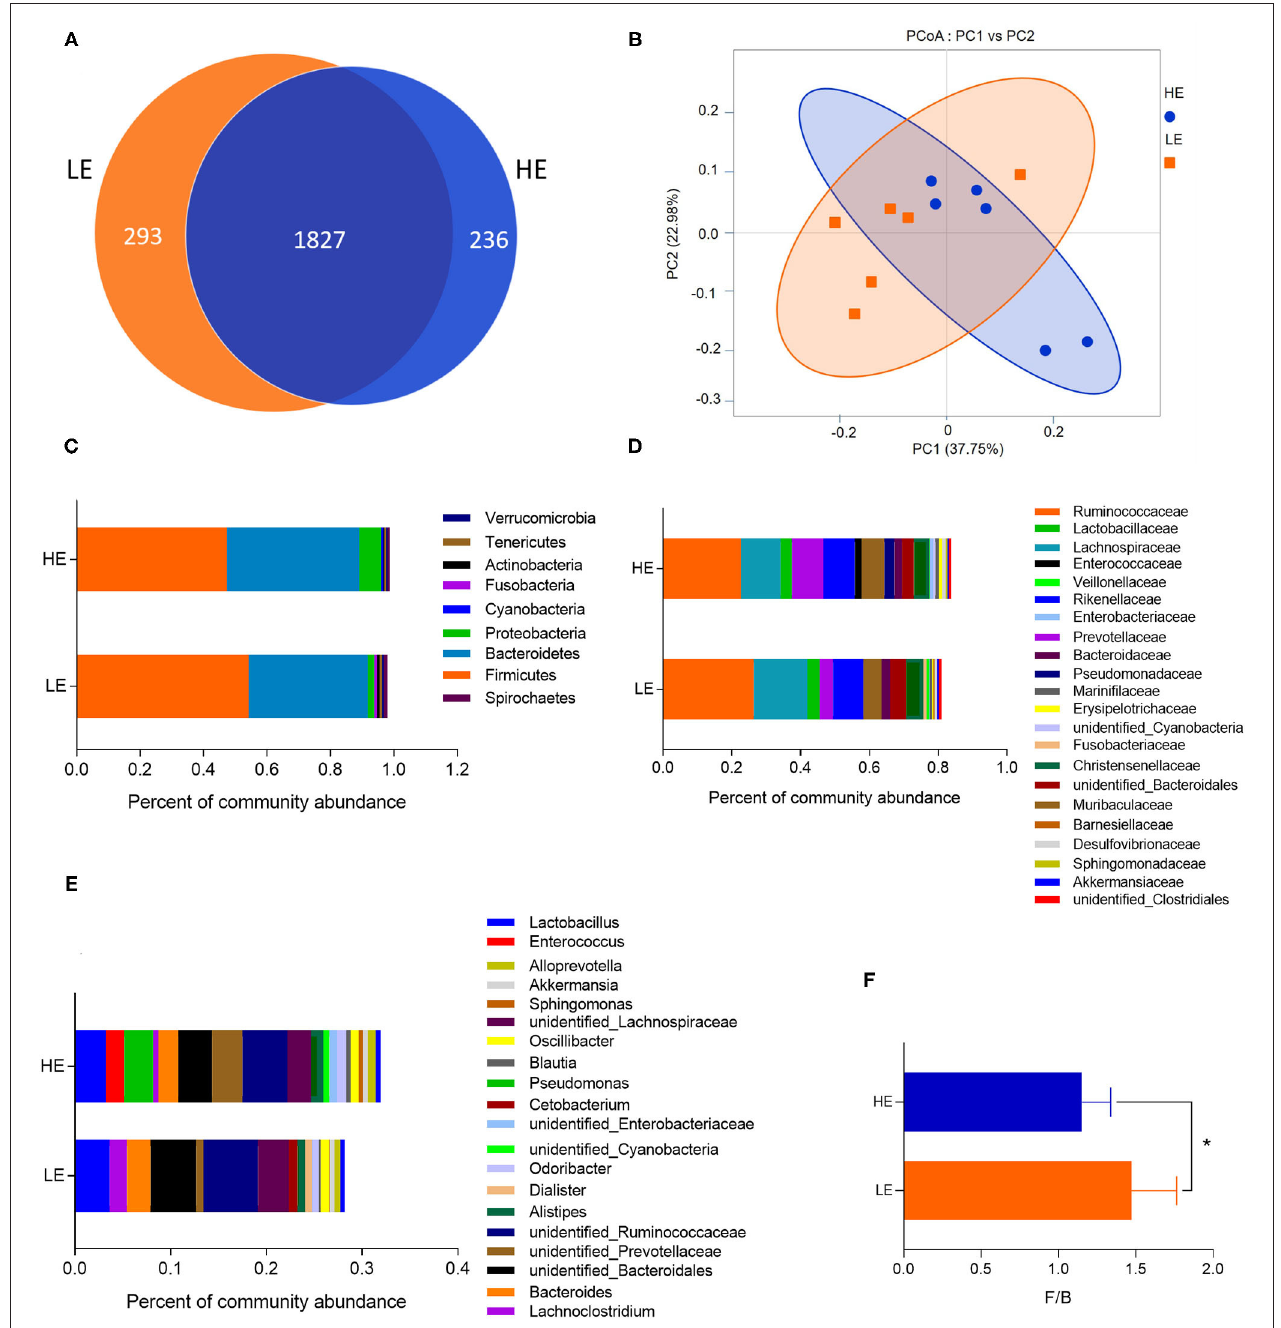
FIGURE 1 | The OTU numbers, beta diversity (PCoA plot), and the relative abundances at the phylum, family, and genus levels of the rectal microbiota of donkeys fed LE or HE diet. (A) Venn diagram of OTUs in the rectal microbiota; (B) principal coordinate analysis (PCoA). The relative abundances of bacteria on the right in each group at the (C) phylum, (D) family, and (E) genus levels. (F) The ratio of Firmicutes and Bacteroidetes. LE and HE represent samples collected in the rectum from donkeys fed LE or HE diet. * means significant difference between the HE and LE group ( p < 0.05). Only microbes that have a mean relative abundance of more than 0.5% are